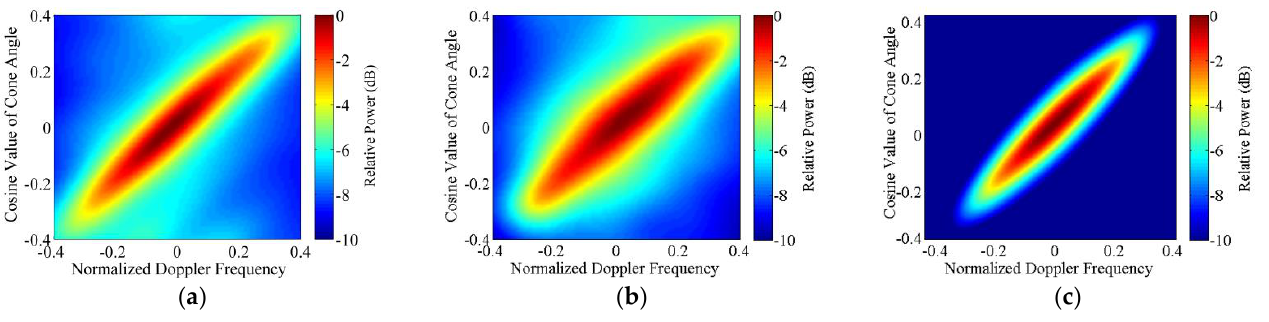
Figure 9. Space-time power spectrum: ( a ) measured data using single range gate and multiple CPIs; ( b ) measured data using multiple range gates and single CPI; and ( c ) simulated data using single range gate and multiple CPIs.